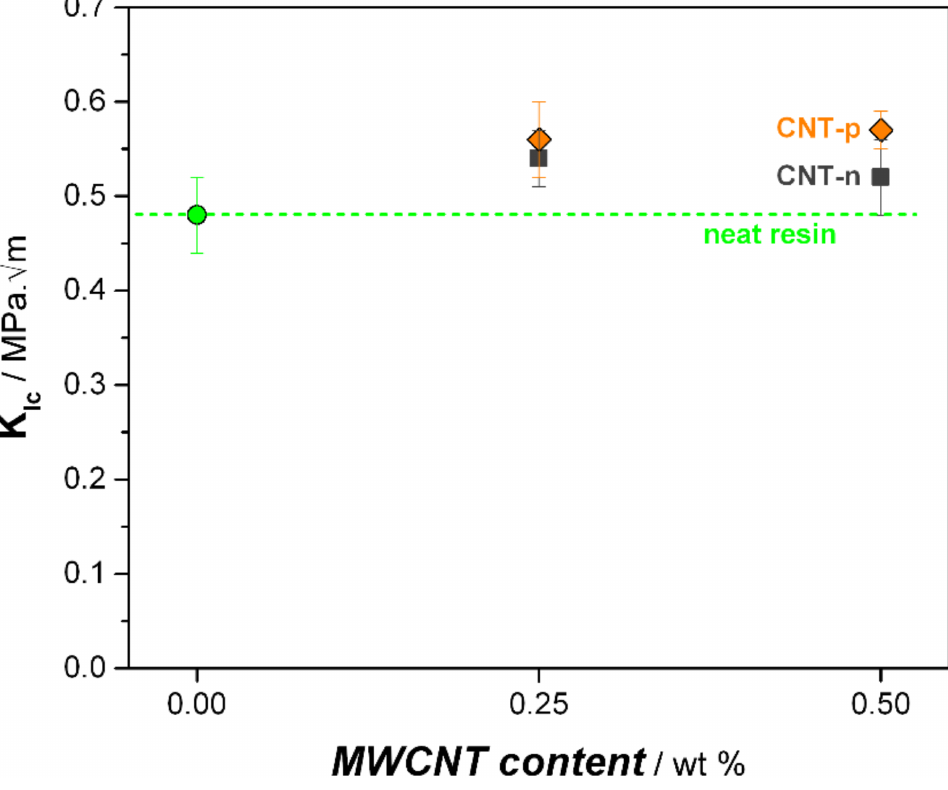
Figure 5. Fracture toughness of neat and MWCNT-modified